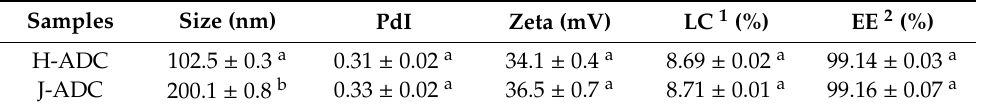
Table 1. Characterization of H-ADC and